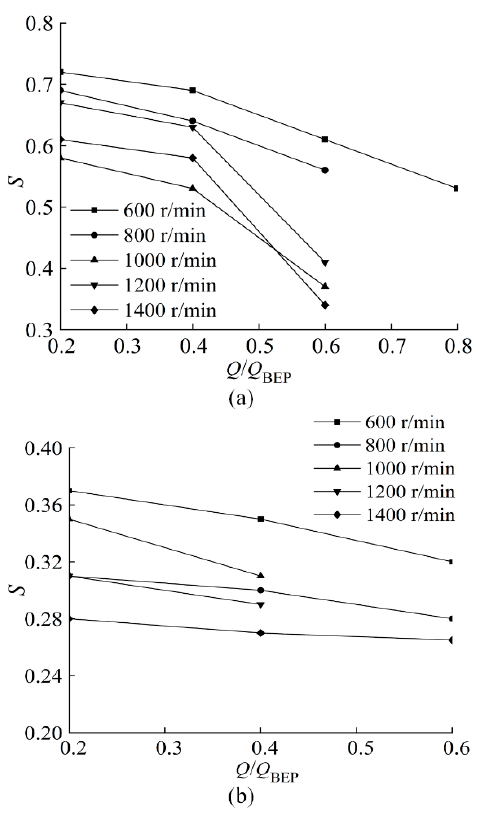
Figure 6. Radial scales of the clockwise vortex ( a ) and the counterclockwise vortex ( b ) at the five rotational